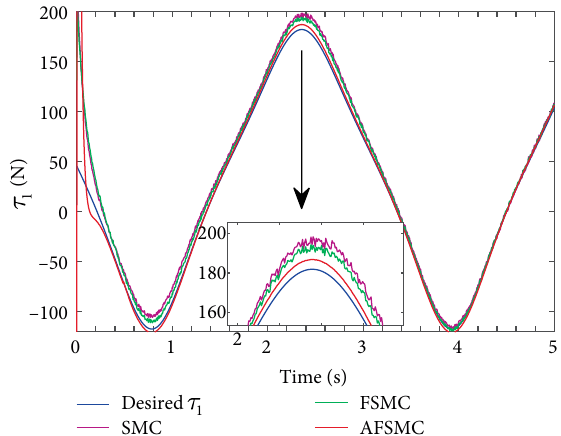
Figure 23: The tracking response of the first driving force